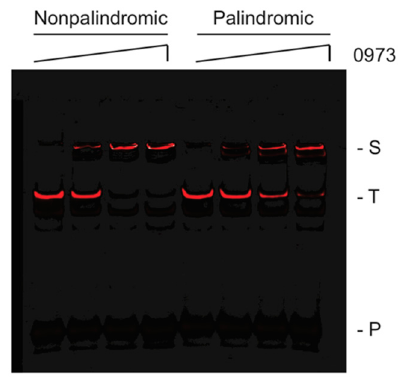
Figure 3. EMSA analysis of TTHA0973-binding to consensus sequences. Shown are IR fluorescence images of IRD700-labeled TTHA0973 nonpalindromic (left) or palindromic (right), as indicated, incubated with 0, 10, 30, or 100 nM TTHA0973 protein. (S) Protein-DNA complex, (T) uncomplexed DNA, (P) IRD7_ST2R primer.